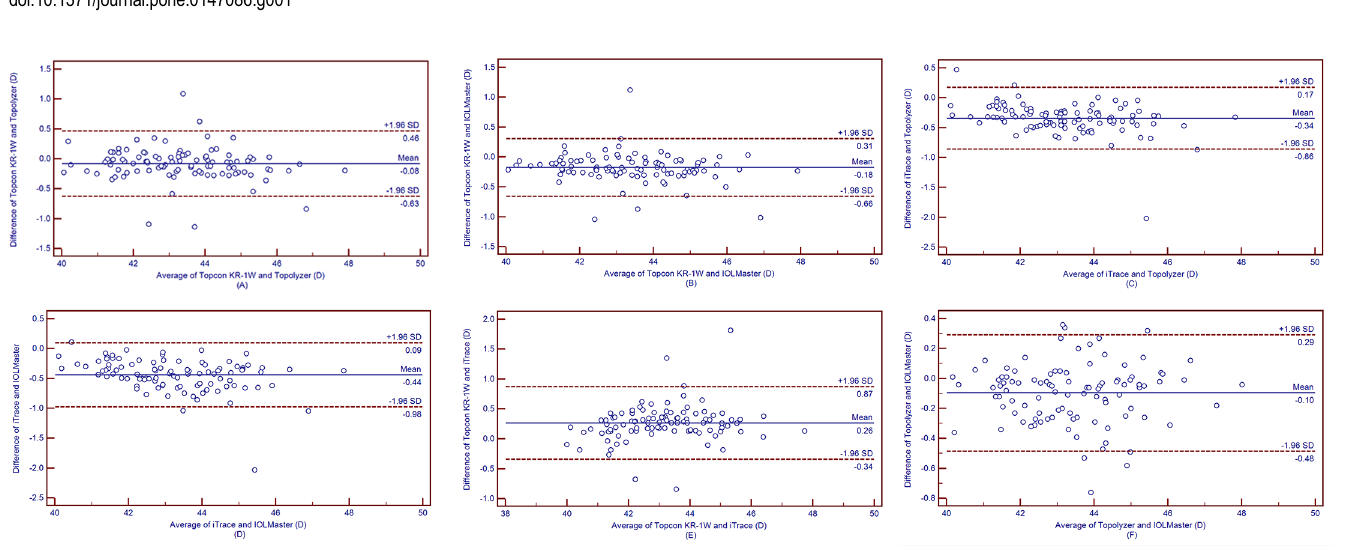
Fig 2. Band-Altman plots present the mean plotted against the differences in values of Kf for a comparison between the Topcon KR-1W and Topolyzer (A), Topcon KR-1W and IOLMaster (B), iTrace and Topolyzer (C), iTrace and IOLMaster (D), Topcon KR-1W and iTrace (E), Topolyzer and IOLMaster (F). The solid line indicates the mean difference. The interval between upper and lower lines represent the 95%